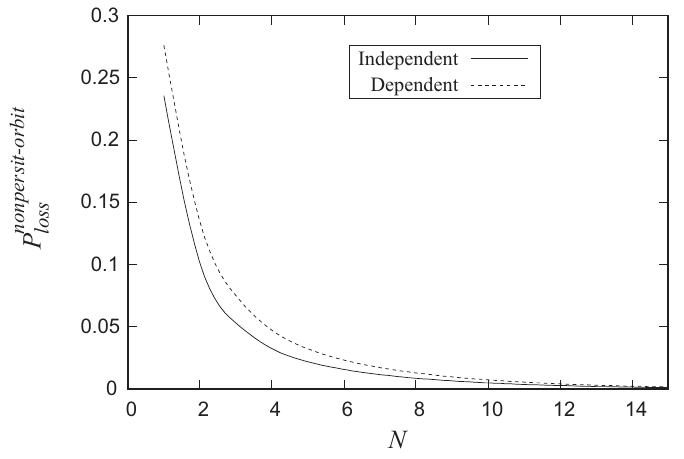
− orbit on the number N . loss